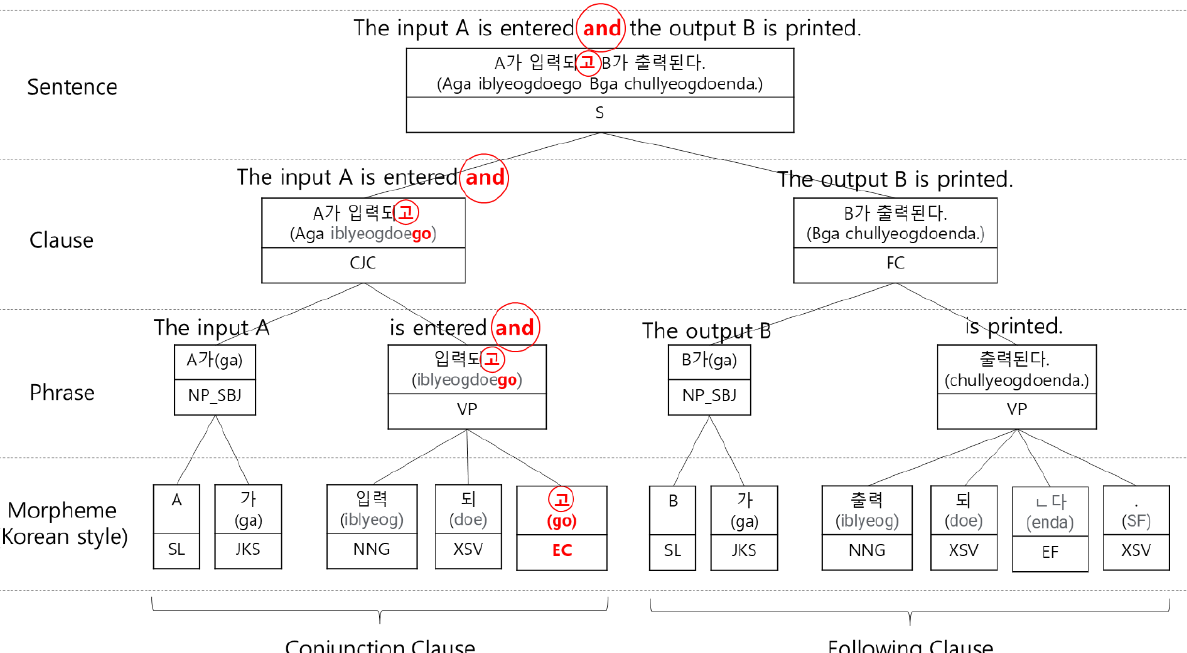
Figure 5. Identification of conjunction